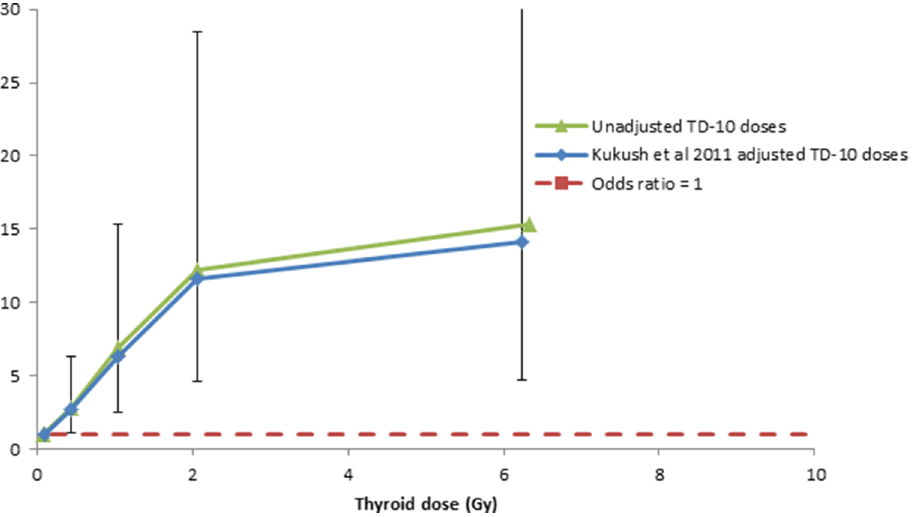
Figure 4. Dose response ( + 95 CI) for thyroid cancer in relation to TD-10 unadjusted dose, and regression-calibration-adjusted dose (using 1 st method, adapted from Kukush etal. [ 13 ] ). The models are adjusted for age (treated categorically) and gender in the baseline. Dashed red line shows odds ratio =1. doi:10.1371/journal.pone.0085723.g004 PLOS ONE |